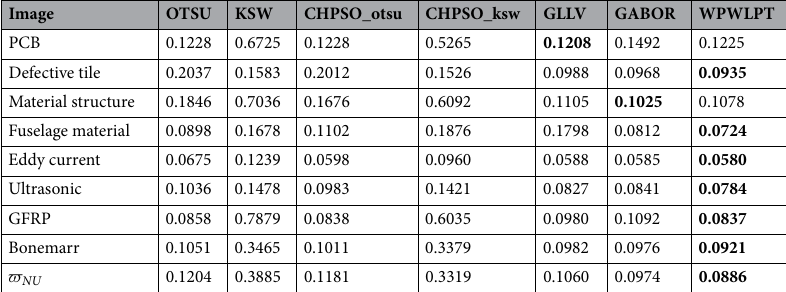
Table 4. NUs of the different thresholding methods. The best results are highlighted in bold.